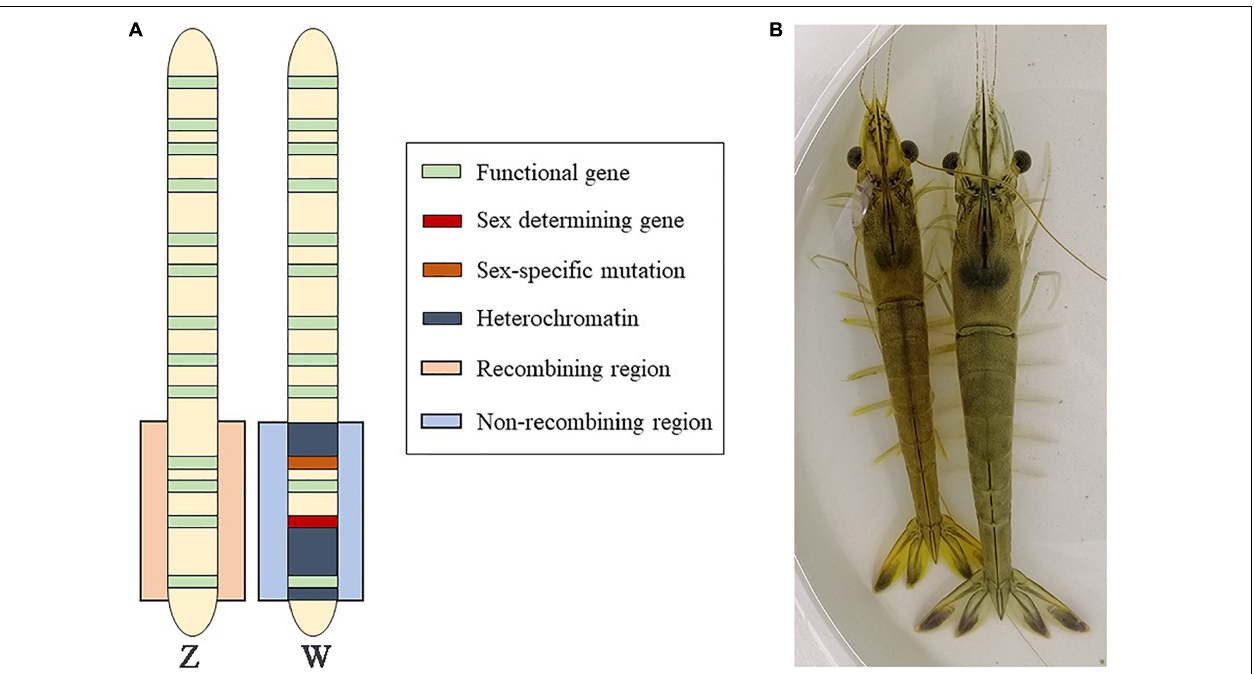
FIGURE 1 | Background for the sex chromosome analysis of F. chinensis . (A) Model of the early-stage sex chromosome. (B) F. chinensis (male on the left and female on the